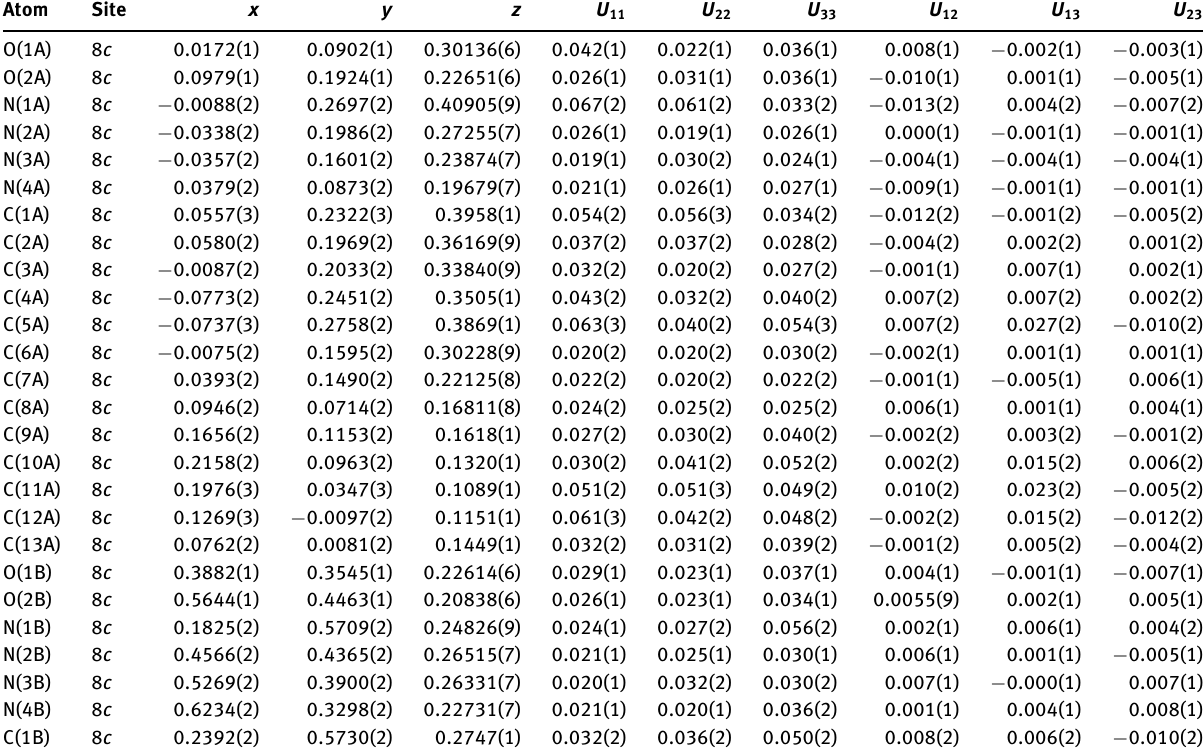
Table 3: Fractional coordinates and atomic displacement parameters (Å 2